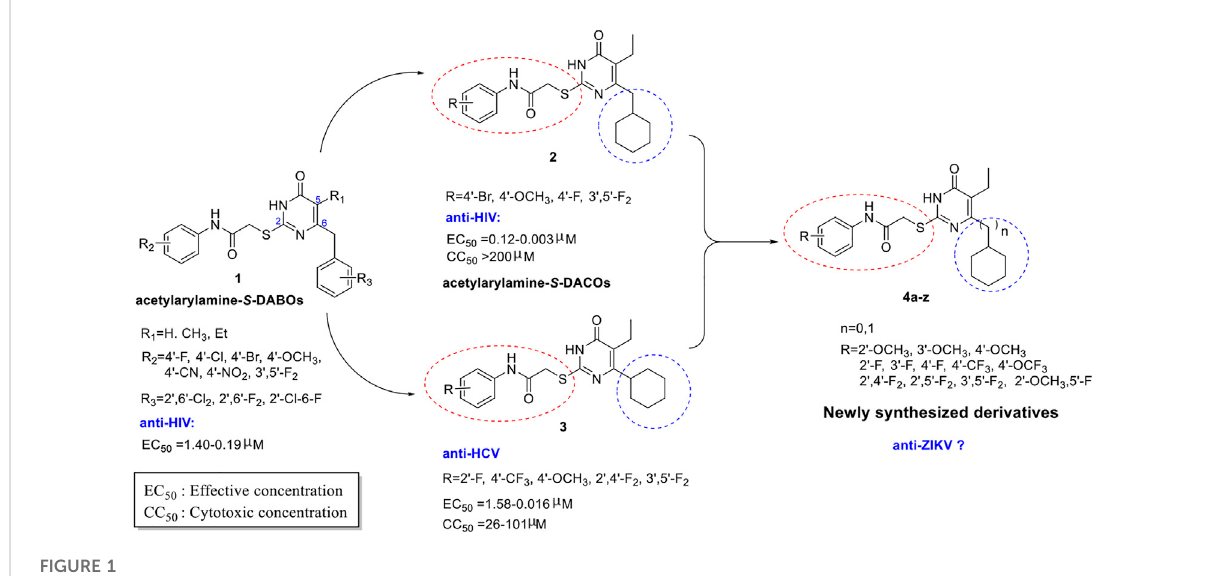
FIGURE 1 The chemical structure of the acetylarylamine- S -DABOs